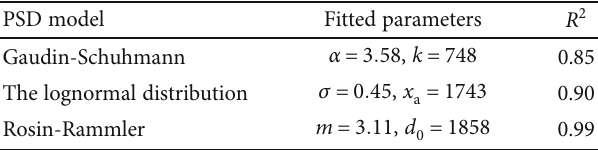
Figure 11: Box diagram of di ff erent particle shape distributions (circularity, form factor, irregularity, aspect ratio, and ellipse ratio) Table 4: Fitted results of di ff erent PSD